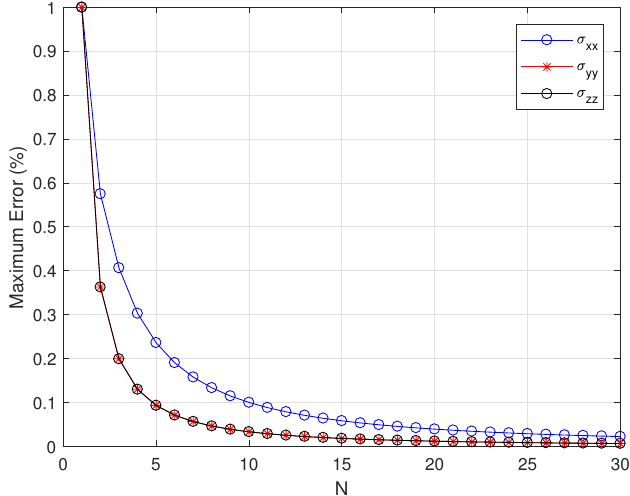
Figure 5. Convergence with N of the maximum error for the stress fields shown in Figure